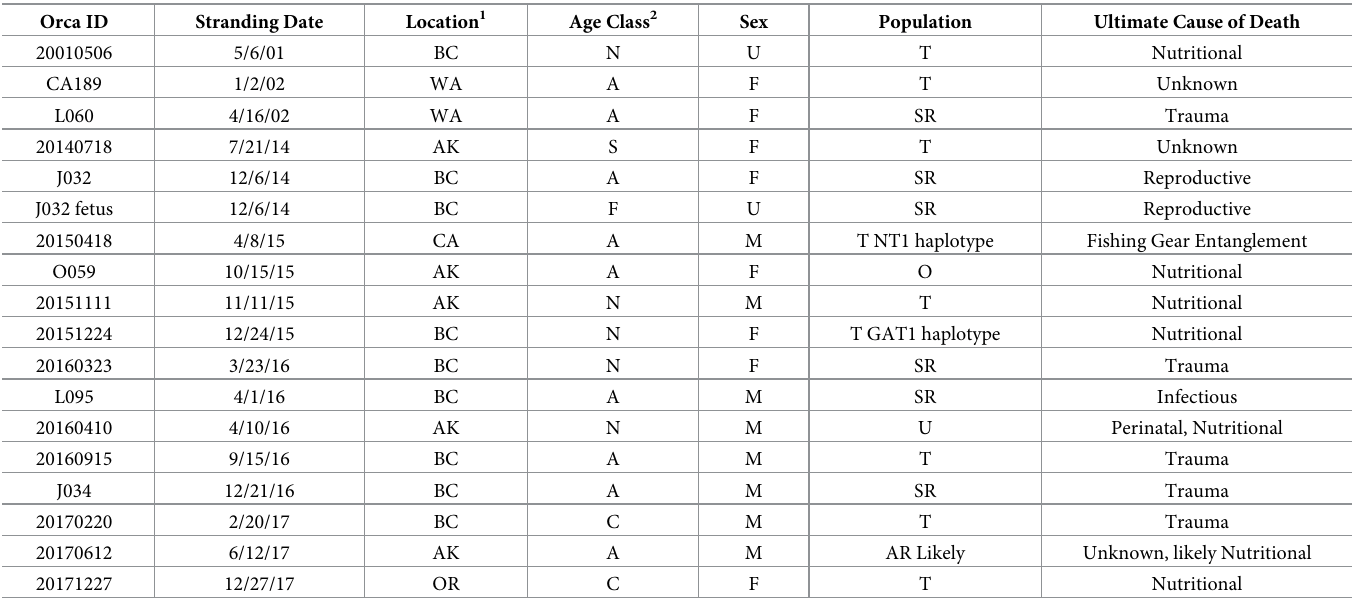
Table 2. Additional stranded killer whales included for body condition index and cause of death